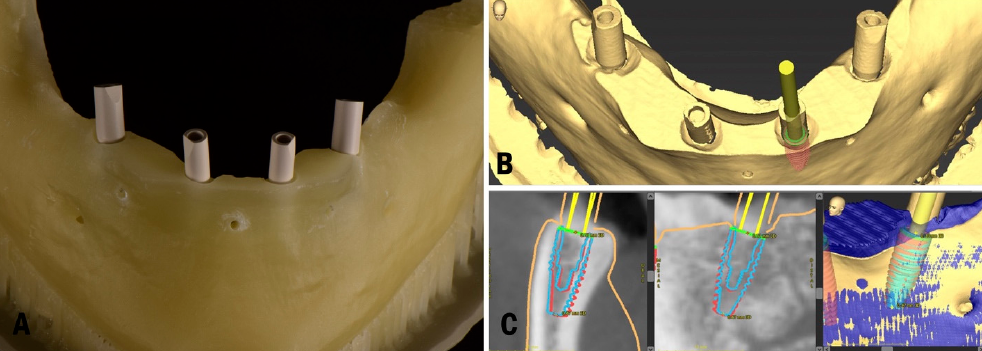
Figure 4. ( A ) Scan bodies mounted on the implants placed in vitro; ( B ) Planning CBCT and postoperative STL matching; ( C ) Accuracy analysis between STL file and scan bodies.